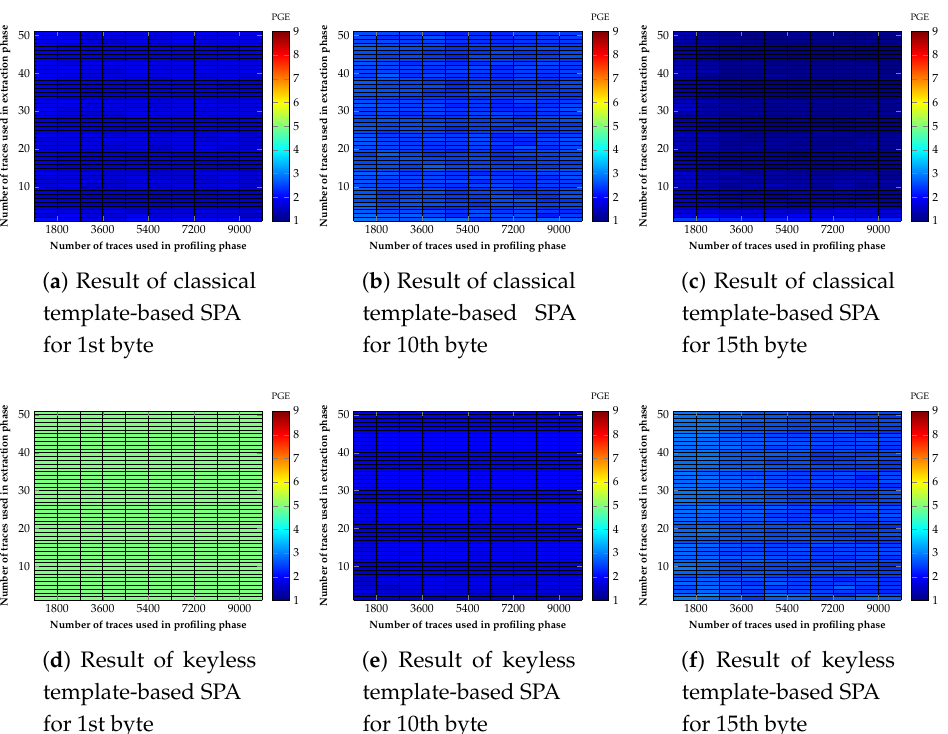
Figure 7. Comparison of results between classical and keyless templated-based SPA when the number of PoI is 1.